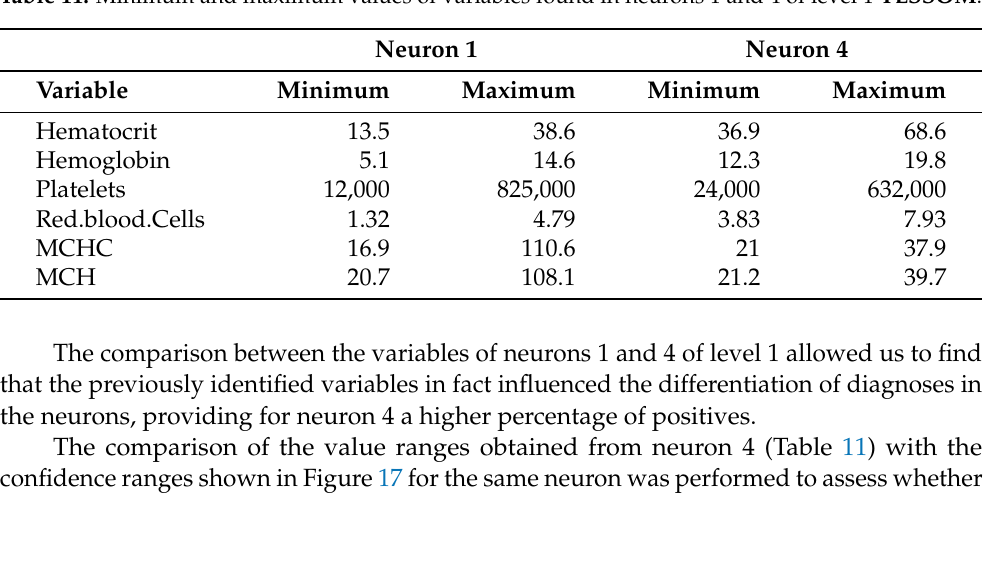
Figure 17. 95% confidence intervals of the variables—level 1— TESSOM . Table 11. Minimum and maximum values of variables found in neurons 1 and 4 of level 1 TESSOM